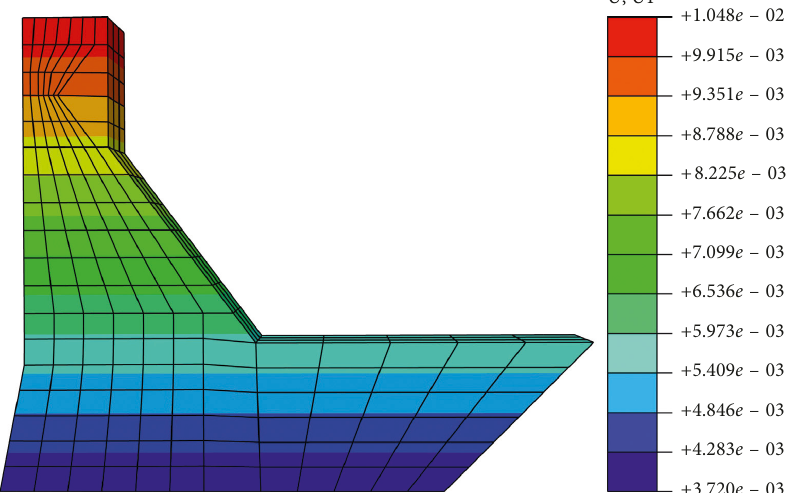
Figure 8: Distribution of the calculated displacement of the selected dam body section.